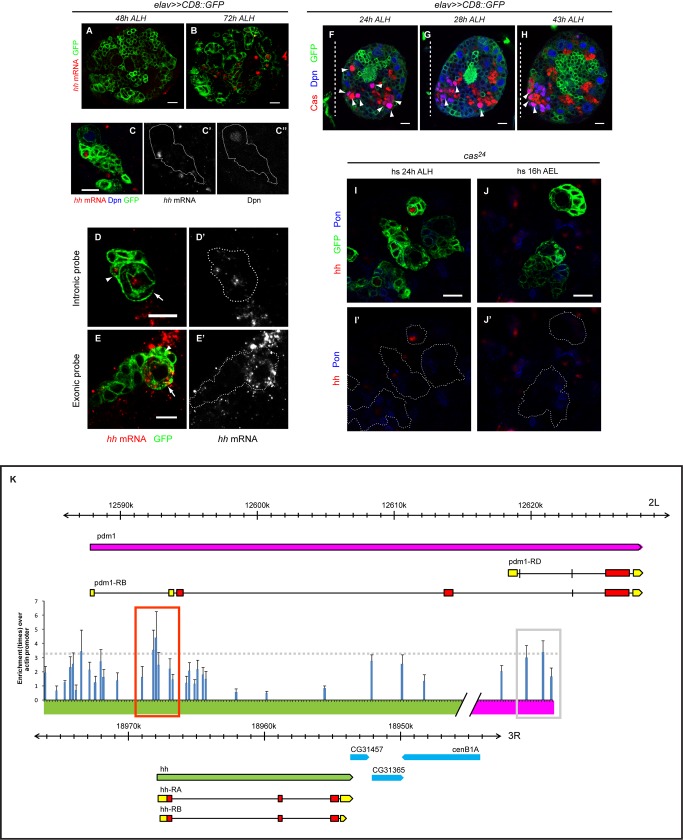
An early transient pulse of Cas is required for later hh expression.(A–B) hh transcript (red) was detected mainly in the GMCs of 72 h ALH brain lobe (B), but not in that of 48 h ALH brain lobe (A). CD8:GFP (green) was driven with elav-Gal4 to mark the outlines of the cells. (C–C″) In situ hybridization of hh (red) in a wt clone showed that the transcript was expressed in the GMC adjacent to the Dpn-expressing NB. (D–D′) In situ hybridization using an intronic probe that detects hh pre-mRNA (red) in a wt clone showing hh expression in the mitotic NB (note the nuclear morphology, arrow), as well as in the GMC next to it (arrowhead). (E–E′) The mature form of hh mRNA (red) was detected in the cytoplasm of the NB (arrow) and to a lesser extent, the adjacent GMC (arrowhead). (F–H) Immuno-staining against Cas (red) showed its expression in cells (NBs and intermediate neural precursors [INPs]) that were also co-expressing Dpn (blue, arrowhead), as well as in some other neurons at different developmental time points. The outlines of the cells were marked with membrane GFP (green). The brain lobes were position such that the dorsal side is facing up and the dotted line indicated the midline of the brain. (I–J′) In situ hybridization of hh mRNA showed that embryonic Cas was required for normal hh expression. cas24 clones induced at 24 h ALH did not affect hh expression (I–I′) while cas24 clones induced during late embryonic stage could reduce or abolish hh expression (J–J′). Pon (blue) showed the outline of the newly born GMCs that typically expressed hh mRNA. (A–F, I–J) Scale bar = 10 µm for all panels. (K) ChIP for Flag-tagged Cas transfected into S2 cells showed that Cas was heavily enriched within the 6-kb region at the 5′ UTR of hh gene (orange box). There are 19 putative Cas binding sites within that region. The enrichment of any region of the chromatin was counted as the multiple of specific binding (anti-Flag) against non-specific binding (anti-IgG), and normalized to the enrichment at the actin promoter site (negative control). A known target of Cas, pdm-1 was used as a positive control (grey box) for comparison purposes. The value of the blue bars was the average enrichment (times) from three independent transfections and five independent ChIPs. Error bar correspond to standard error of the mean (SEM).